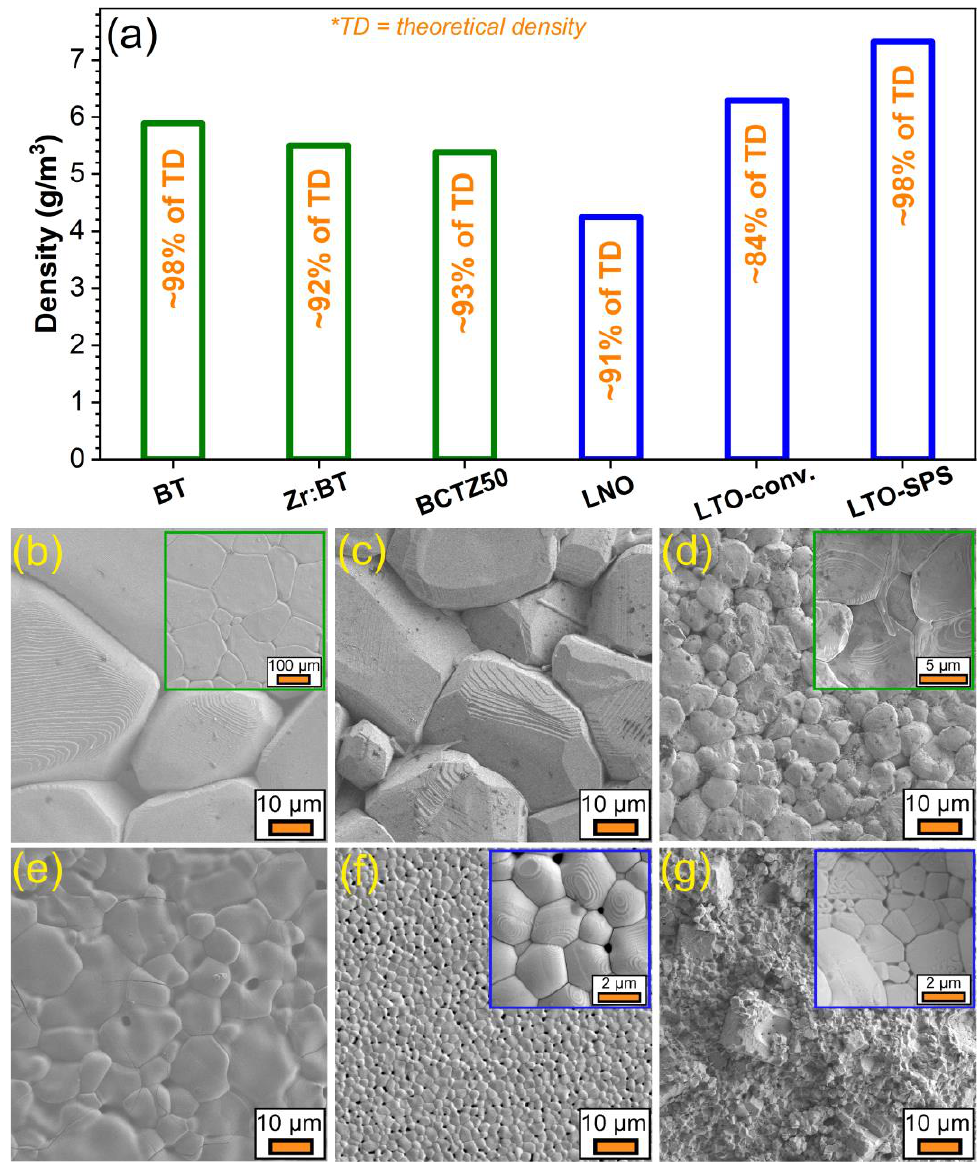
Figure 3. ( a ) Density values of the sintered piezoceramic materials. FE-SEM morphology of the conventionally sintered ( b ) BT; ( c ) Zr:BT; ( d ) BCTZ50; ( e ) LNO; and ( f ) LTO and ( g ) spark plasma sintered LTO ceramic disks. Insets: FE-SEM images collected at: lower magnification in the case of ( b ) BT, to enable the visualization of the general morphology of the sintered disks, and at higher magnification for the finer grained materials—( d ) BCTZ50; and both ( f ) conventionally and ( g ) spark plasma sintered LTO, to disclose the morphology and size of the constituting grains.